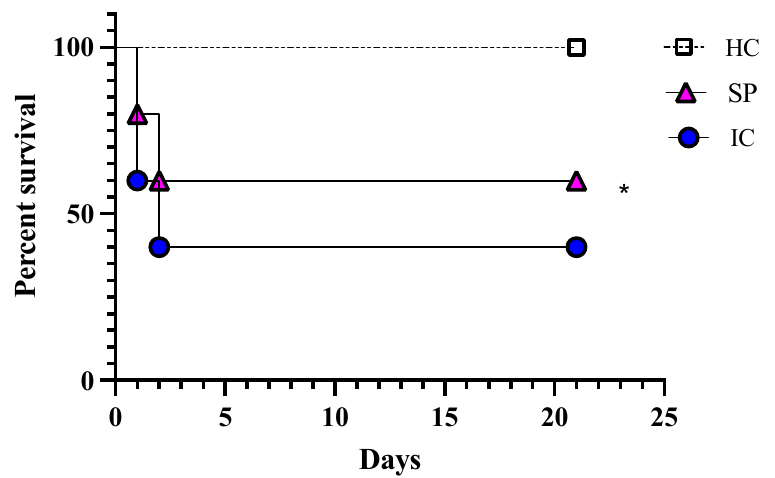
Figure 5. Survival probability of C. glabrata secretome-immunized mice. The survival proportion states the potency of secreted proteins in protection against infection caused by C. glabrata compared to the un-immunized group. A Mantel–Cox log-rank test (n = 10 mice/group) was used to compare the survival of mice in different groups. HC, healthy control group; SP, secreted protein; IC, infection control. * p = 0.0171.